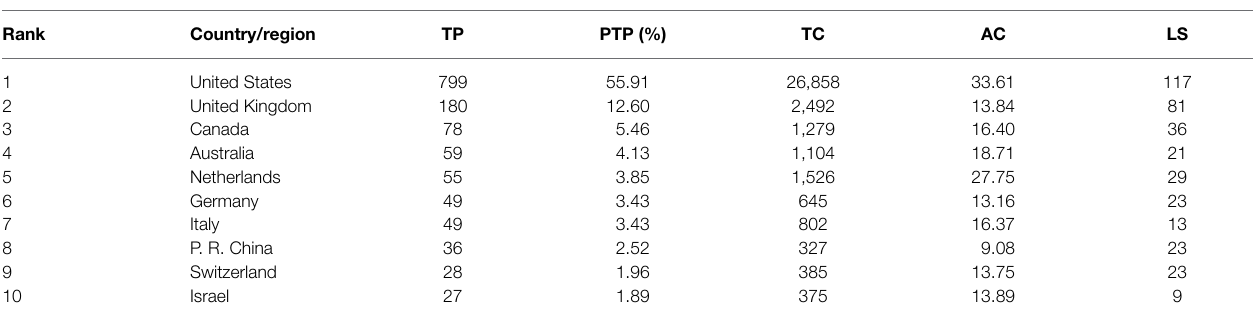
TABLE 2 | The top 10 contributive